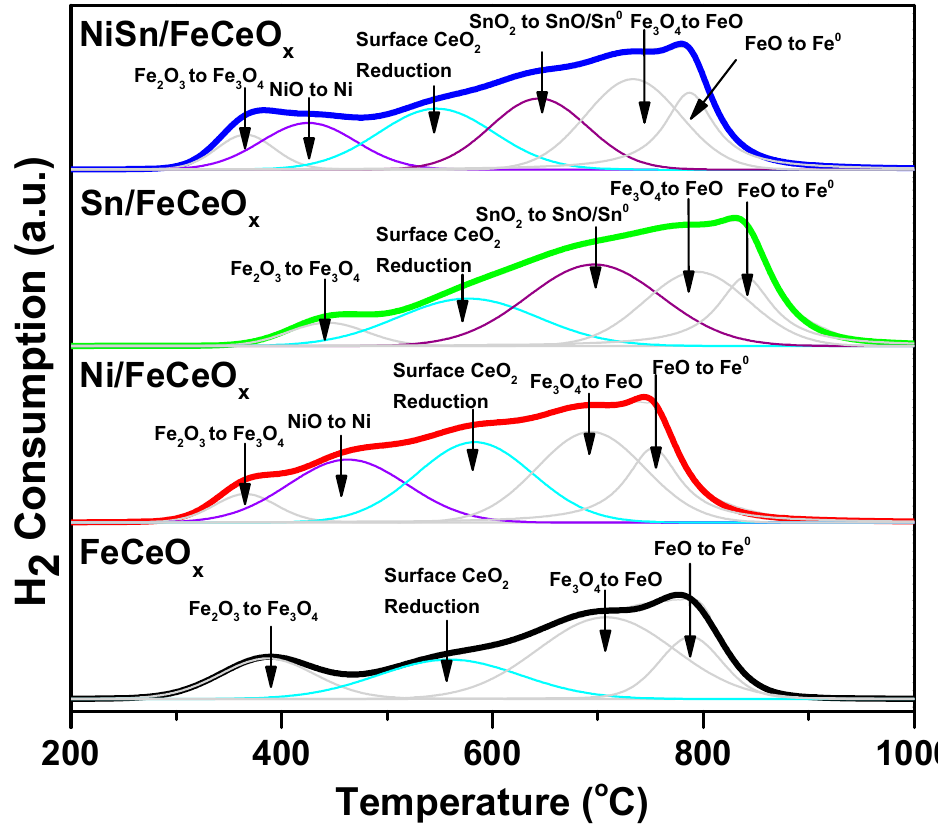
Figure 5. H 2 -Temperature-Programmed Reduction (H 2 -TPR) profiles of fresh FeCeO x , Ni / FeCeO x , Sn / FeCeO x , and NiSn / FeCeO x catalysts.